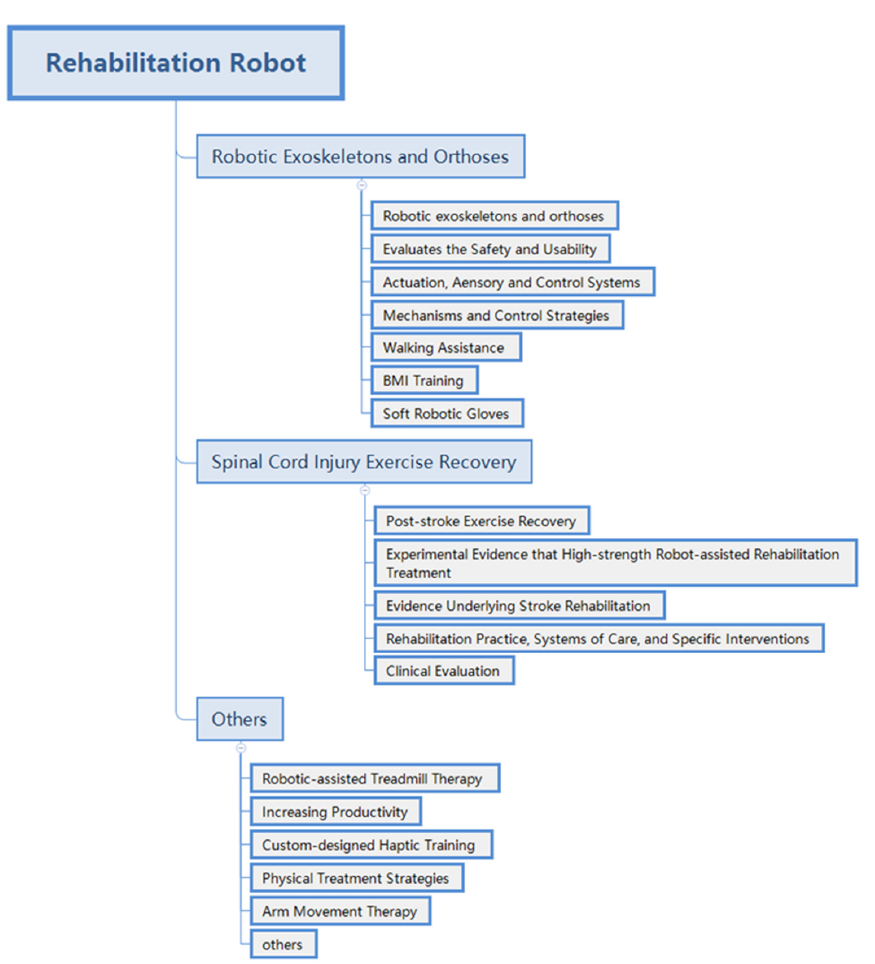
Figure 8. Technical concept tree diagram drawn from the knowledge base of the clusters.